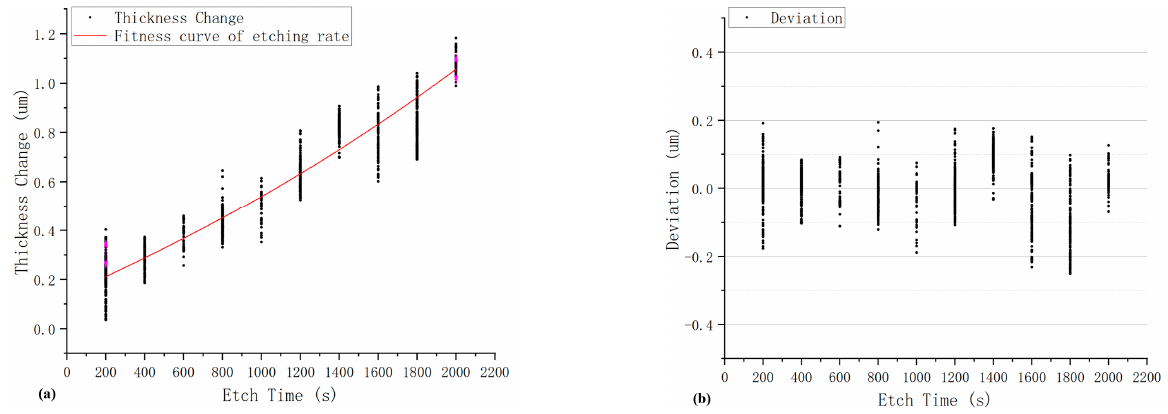
Figure 10. Etching rate of anhydrous etching solution at 60 °C: ( a ) etching rate; ( b ) deviation.